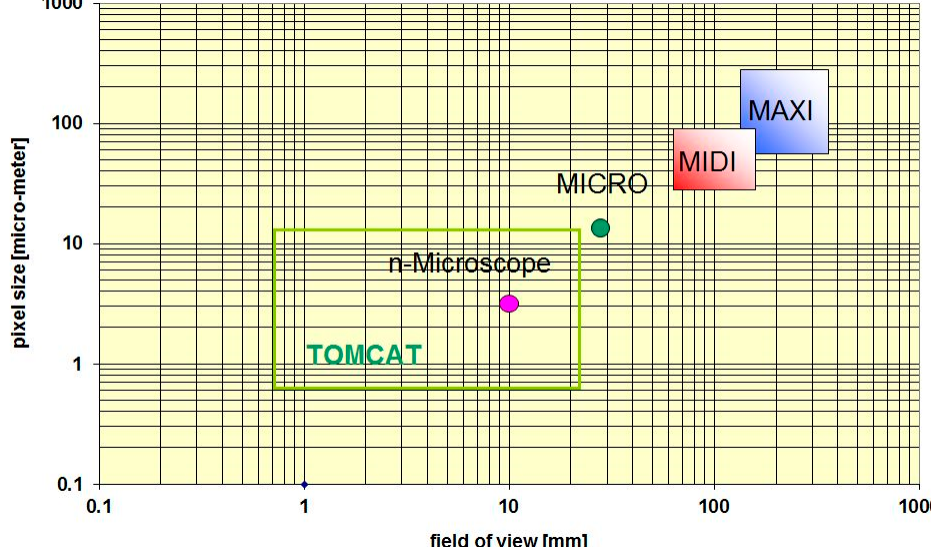
Figure 3. Working areas of camera based detection systems with respect to field-of-view (FOV) and pixel size (the logarithmic scale needs to be considered); corresponding conditions at the synchrotron beam line TOMCAT [10] are added for comparison; MAXI (up to 40 cm); MIDI (up to 15 cm); MICRO (fixed to 27 mm FOV); n -Microscope (5–10 mm FOV).